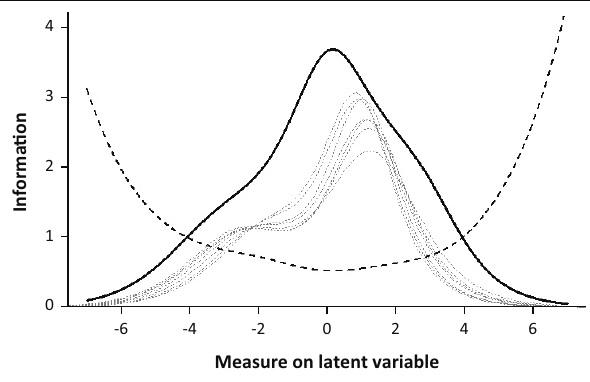
FIGURE 2: Test information function and standard error of measurement. Item information functions given as dashed grey lines. These information indices were scaled by 4 on the Y -axis for ease of